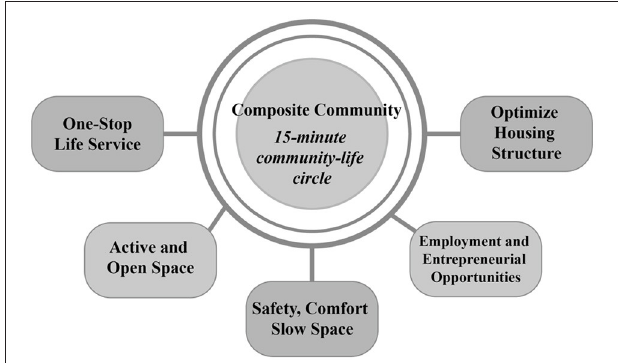
FIGURE 7 | Composite community (Source: adapted from Mei, 2020, p.20).